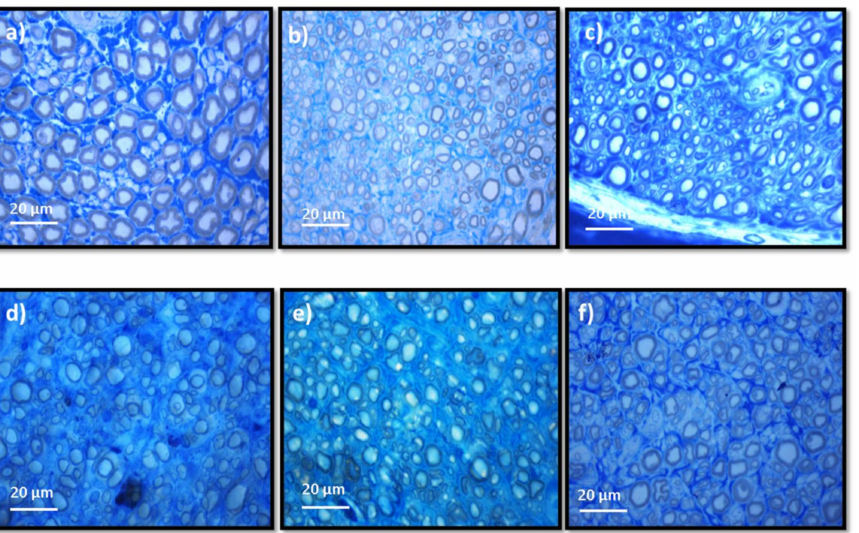
Figure 10. Light micrographs of toluidine blue-stained sciatic nerve semithin sections for the different groups: ( a ) UC; ( b ) EtE; ( c ) CMOM; ( d ) ECMOM; ( e ) CMOEC; ( f )